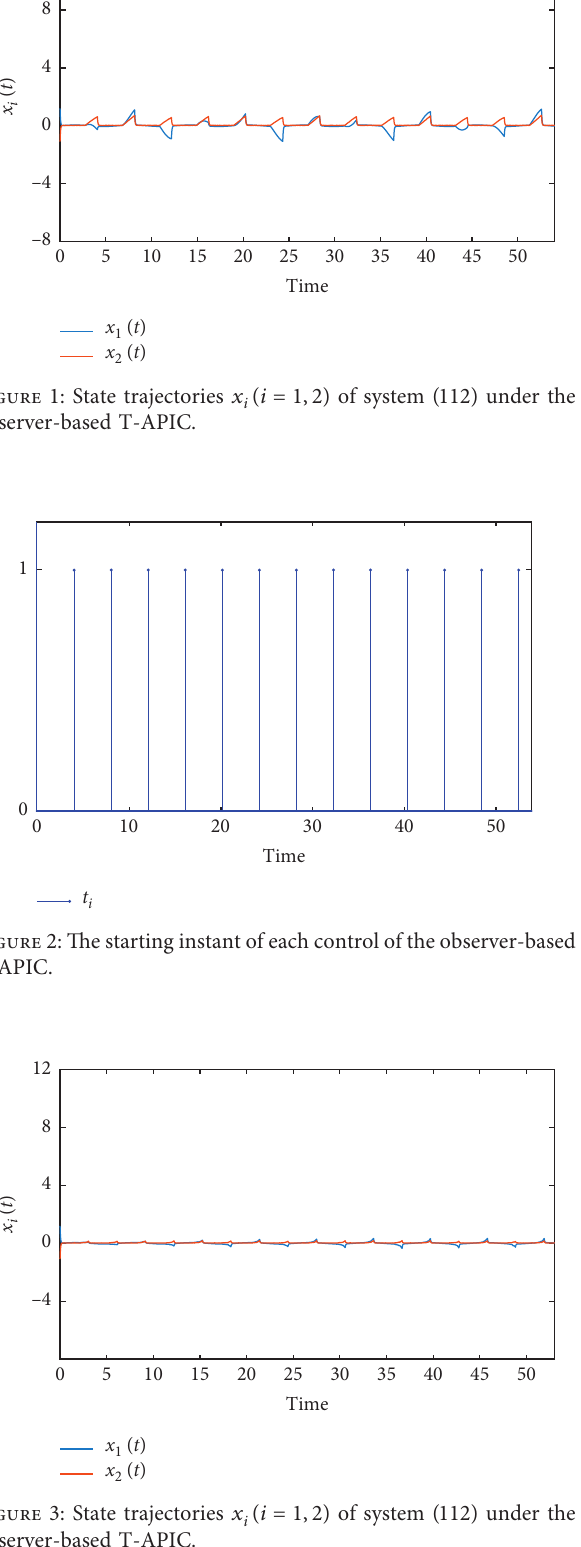
Figure 6: The starting instant of each control of the observer-based